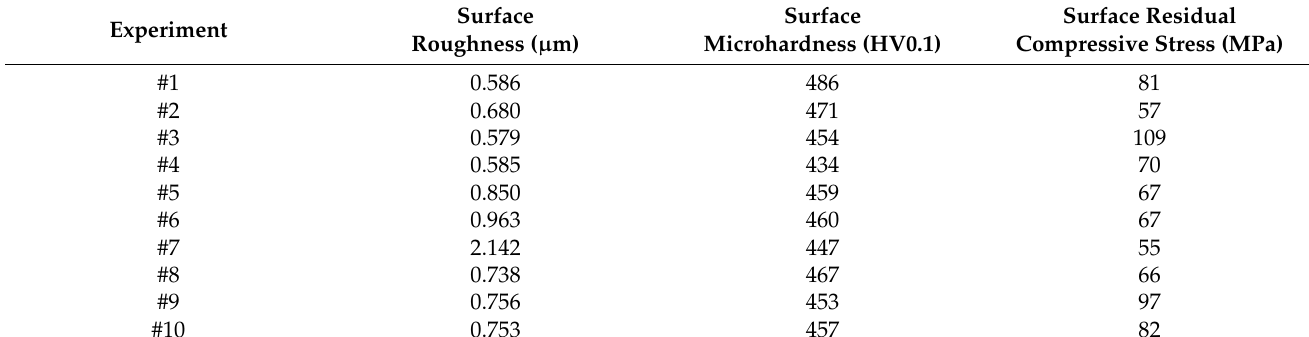
Table 4. Data of surface integrity obtained in cutting experiments.